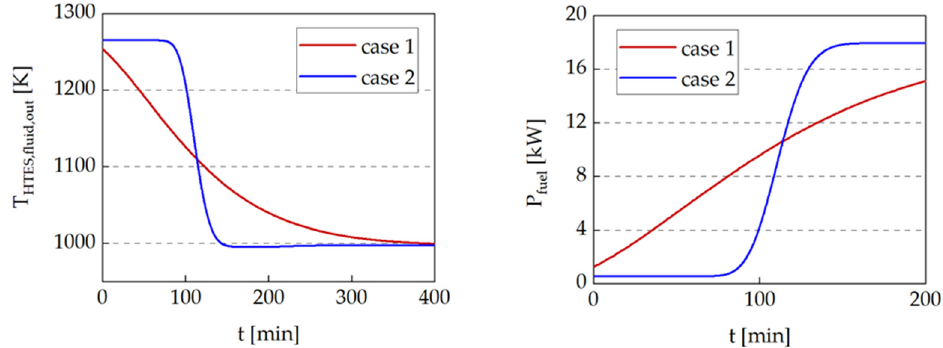
Figure 5. ( Left ): Temperature profiles of different HTES set ups presented in Table 2, ( right ): influence of the different HTES cases on the fuel demand of the MGT as a function of time.